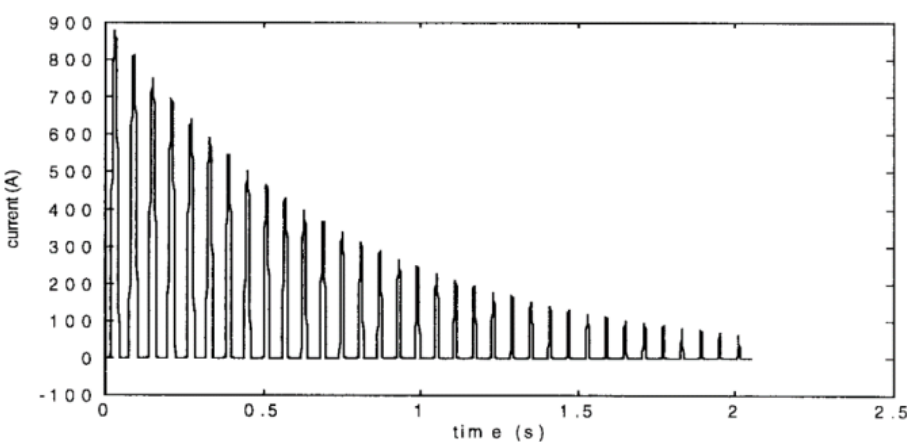
Figure 14. Measured inrush current transient in Switzerland BLS Re465 locomotive [105].